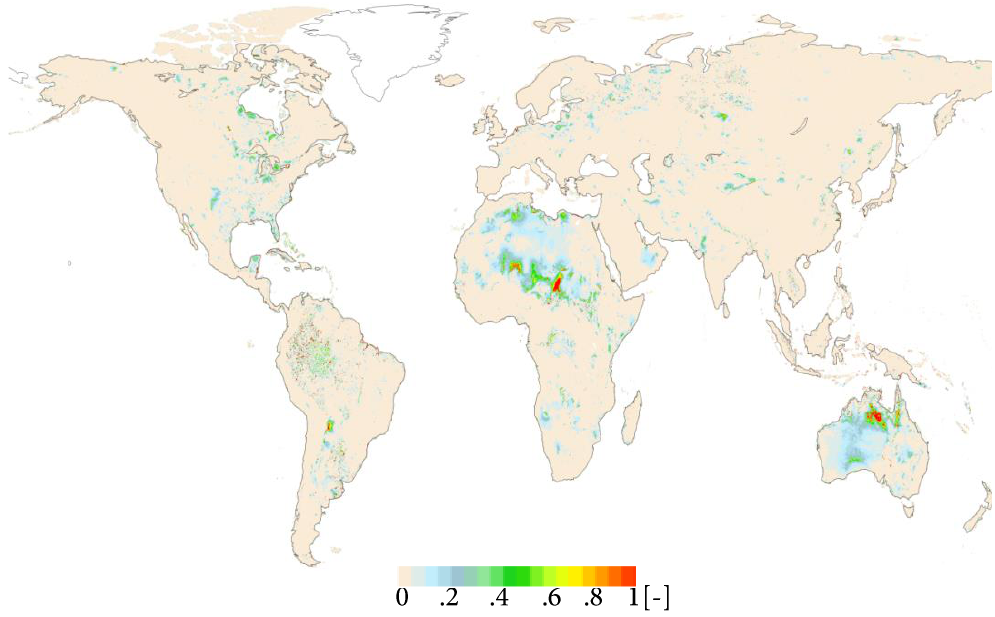
Figure 5. Coefficient of variation of groundwater depth of 1000 runs with different parameter settings for aquifer thickness, saturated conductivity and groundwater recharge.